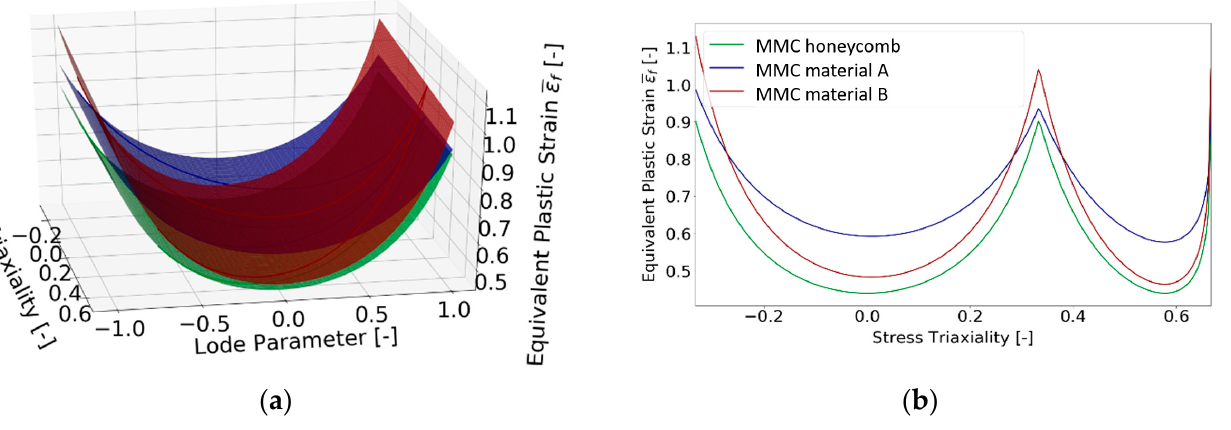
Figure 18. Comparison of MMC model for material 316L from different suppliers (material A—blue color, material B—red color) [47] and honeycomb (current study—green color) ( a ) in Haigh- blue color, material B—red color) [48] and honeycomb (current study—green color) ( a ) in Haigh- Westergaard space, ( b ) for plane stress condition. Westergaard space, ( b ) for plane stress condition.